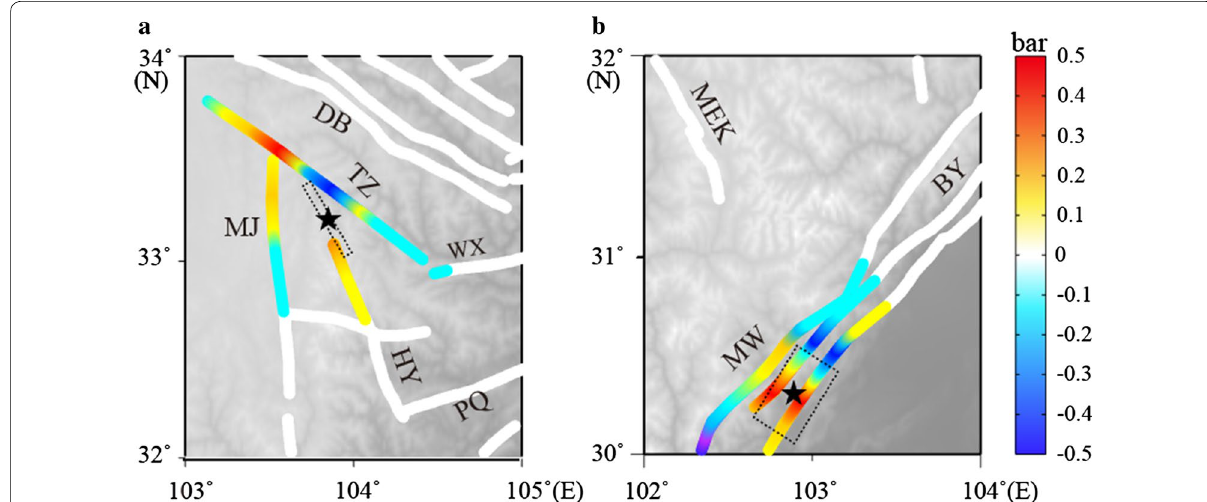
Fig. 5 Stress changes on the nearby active faults caused by the two earthquakes. a The 2017 Jiuzhaigou earthquake. b The 2013 Lushan earthquake. Dash lines denote the source